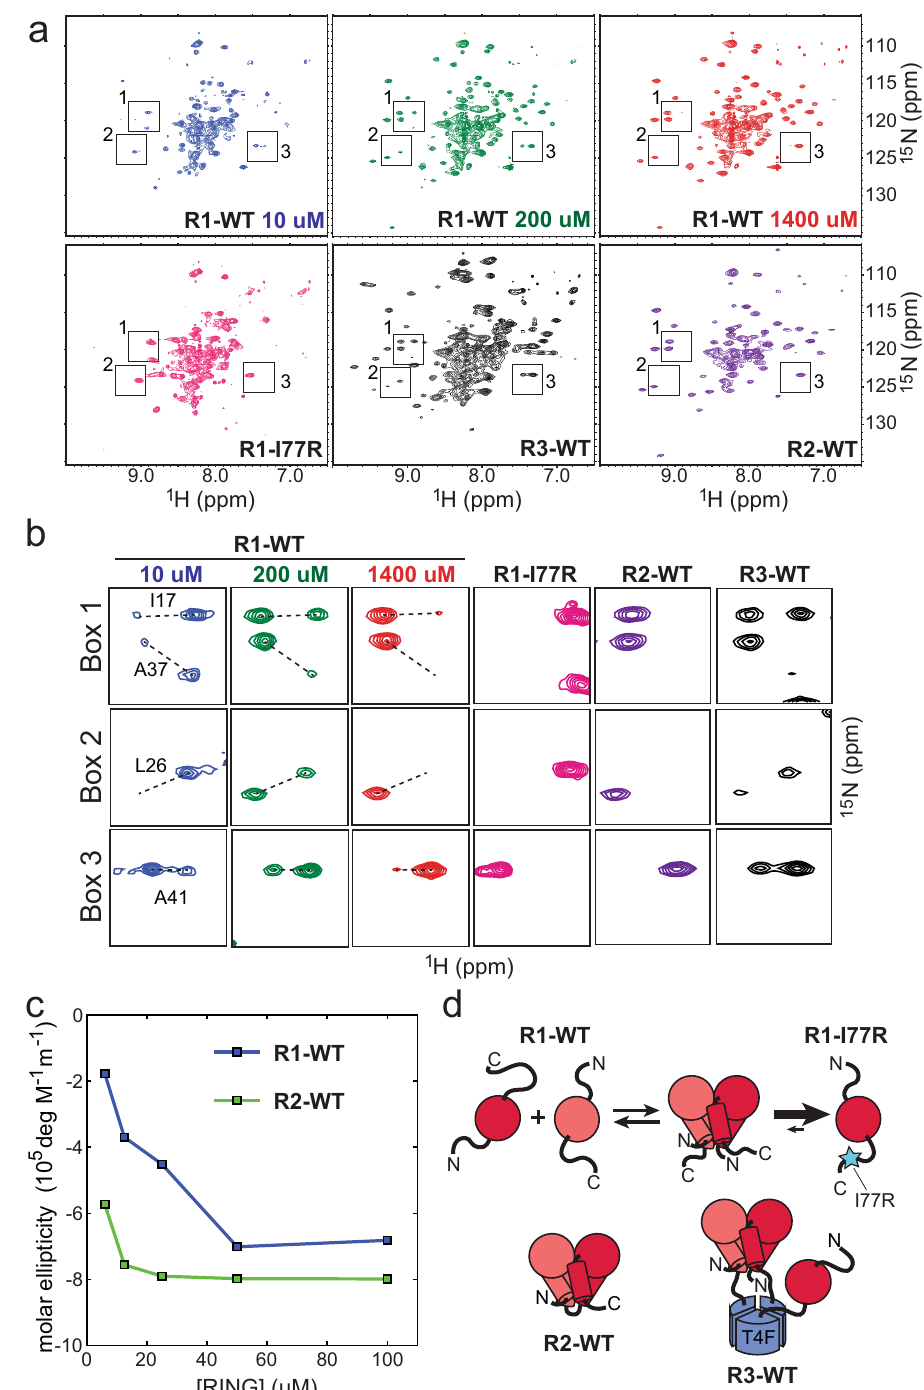
Fig. 2 | Conformational repertoire of distinct RING constructs as revealed by NMR spectroscopy and circular dichroism. a 15 N-TROSY HSQC spectra of dif- ferent RING constructs reveal spectral signatures of RING dimerization. b Three representative spectral regions from ( a ) showing NMR signals that display dis- tinctive chemical shift changes upon transition between the monomeric and the